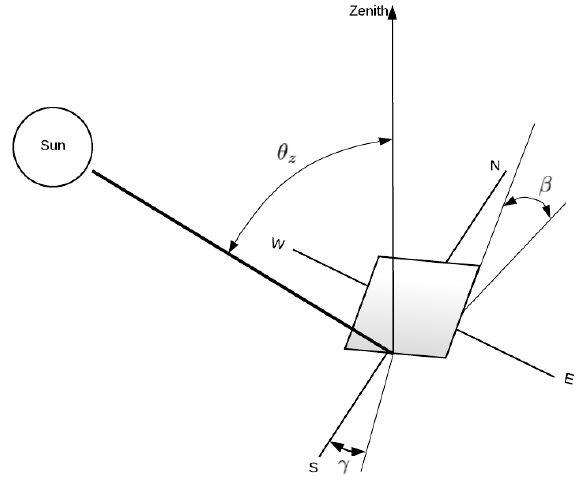
Figure 2. Set of angles of a inclined